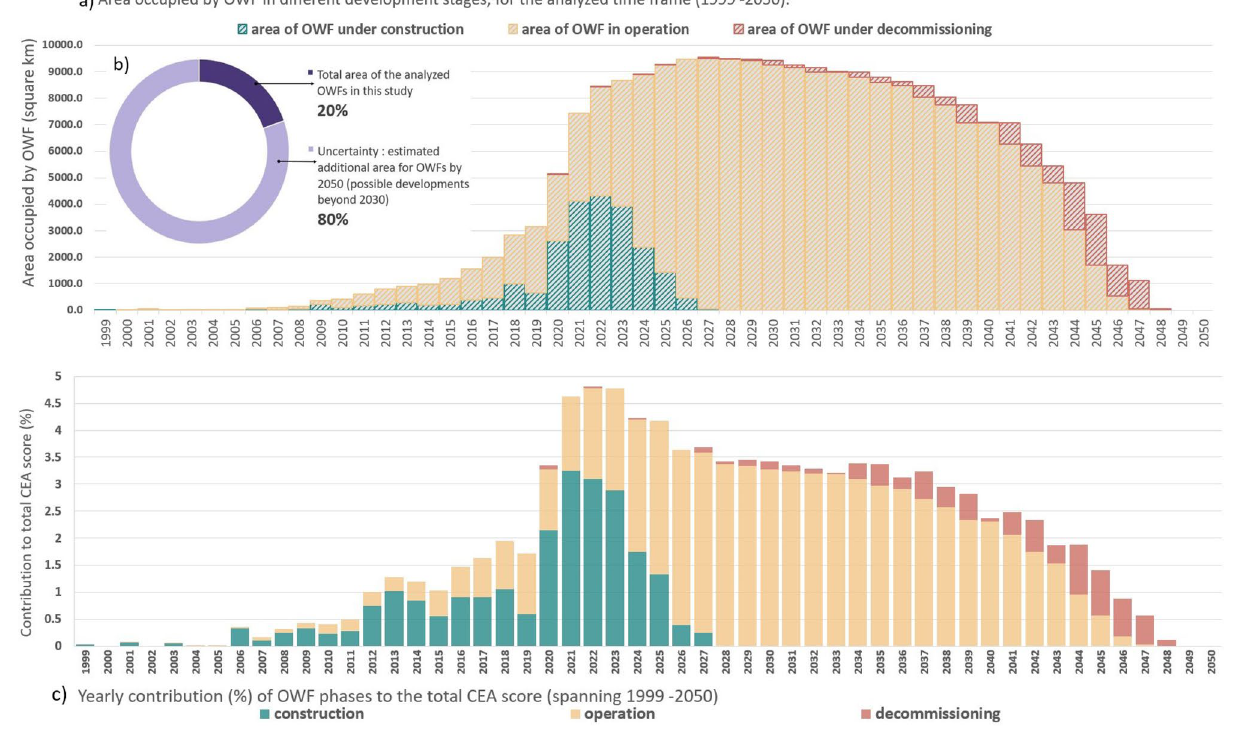
Figure 1. ( a ) Area occupied by OWFs in different development stages, for the analysed time frame (1999– 2050); ( b ) estimated additional area for OWFs by 2050 (search areas, development areas, scoping areas for deployments beyond 2030)—uncertainty; ( c ) yearly contribution (%) of OWF phases to the total CEA score (spanning